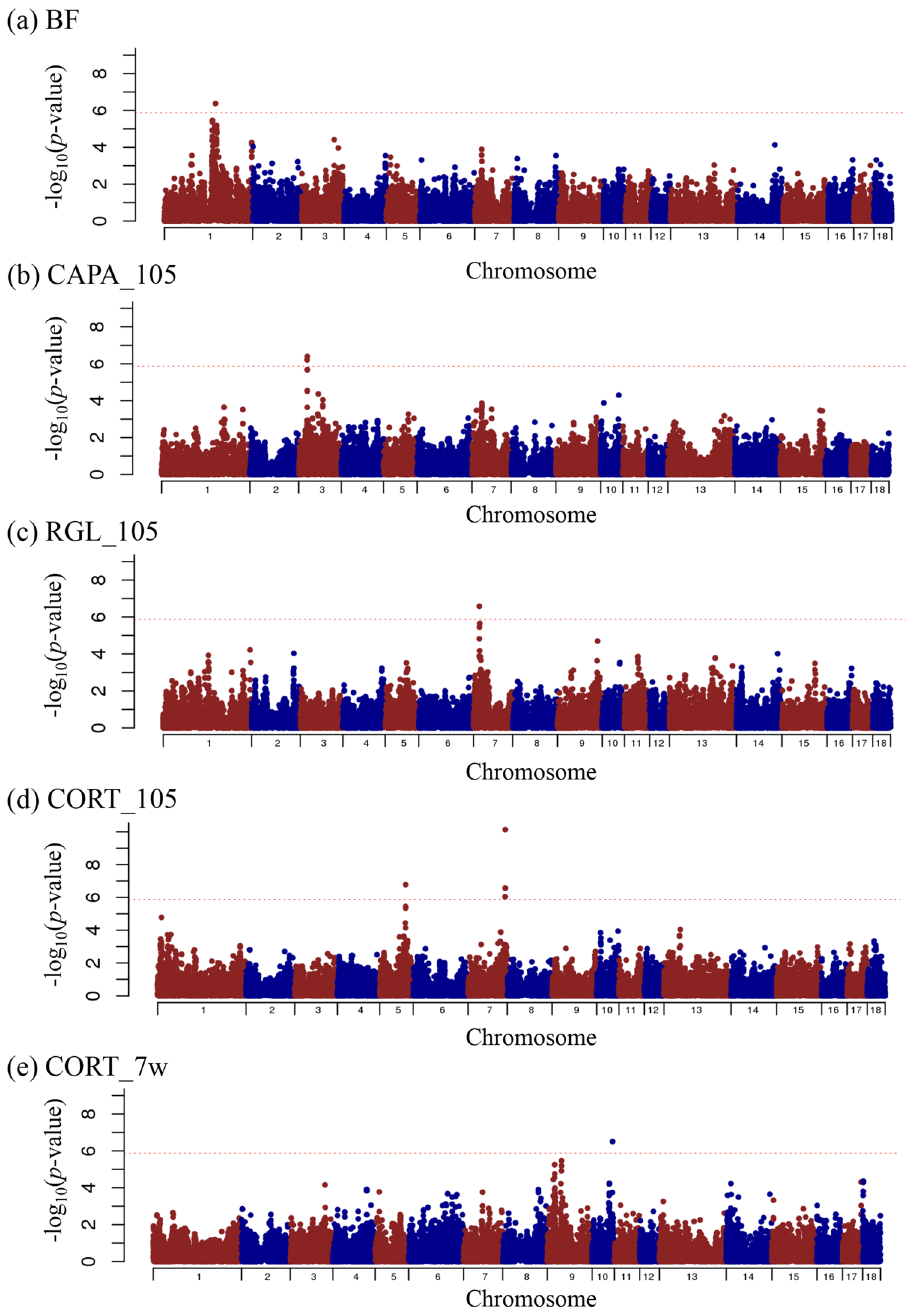
Figure 1. Manhattan plots representing the single nucleotide polymorphism (SNP)-based genome-wide significant association with production and immune-related traits in Landrace pigs. Abbreviations of the traits for BF (a) , CAPA_105 (b) , RGL_105 (c) , CORT_105 (d), and CORT_7w (e) are shown in Table 2. The x-axis indicates the chromosome number and the y-axis indicates –log 10 ( p -value). The dotted horizontal line indicates the significant